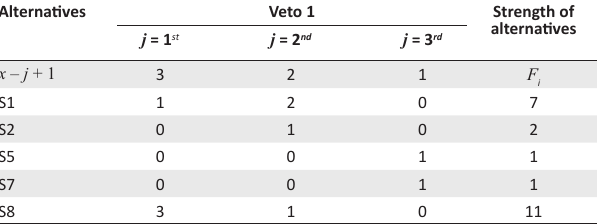
TABLE 12: Veto stage to the upper quartile.